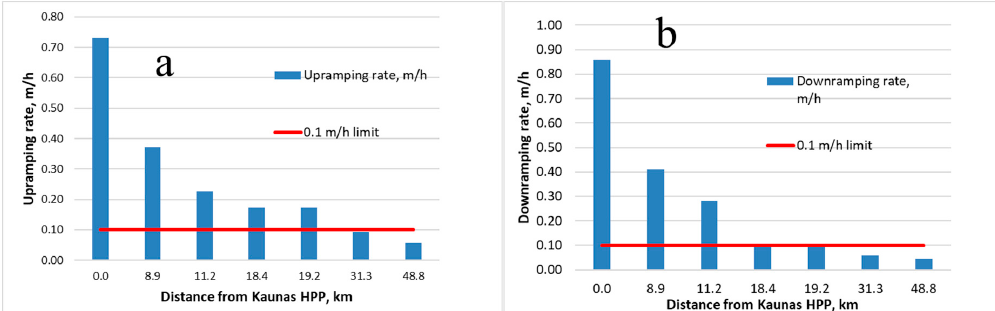
Figure 10. Dynamics of stage fluctuations downstream from Kaunas HPP during average flow period: ( a ) upramping; ( b ) downramping. Red line: stage fluctuation limit assigned for natural flowing rivers (0.1 m/h).